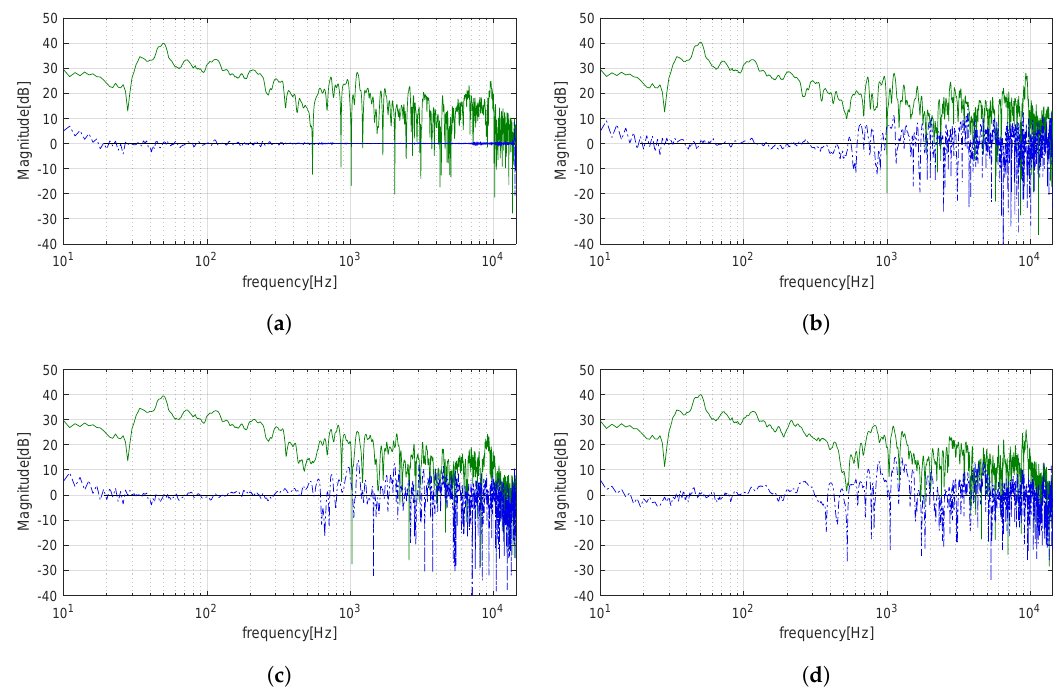
Figure 8. Frequency response at microphone M2 ( a ); microphones PM1 and PM2 ( b , c ), corresponding to small forward and backward head movements; microphones PM3 ( d ), corresponding to a large lateral head movement. Table 5. Audio equalization results for microphone M2 and microphones PM1, PM2 and PM3. The evaluation is achieved by the experiments performed using the Jeep Renegade with four microphones (see Table